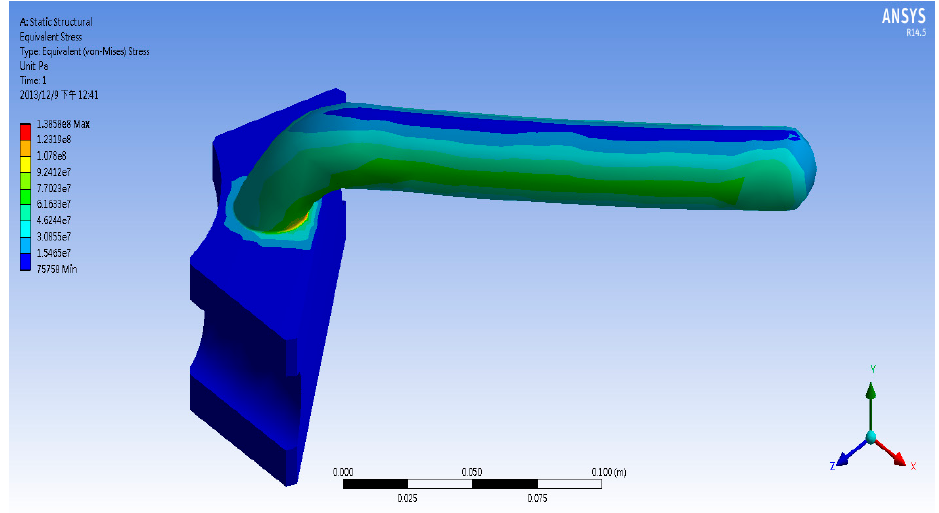
− 49.1267 Figure 6. Factor S/N ratio of the new spanner. From the response diagrams of each factor, it can be seen that the best level combi- nation should be A3B2C3D3 and the optimal design size shown in Table 3. Table 3. Optimal design size combination. Factor